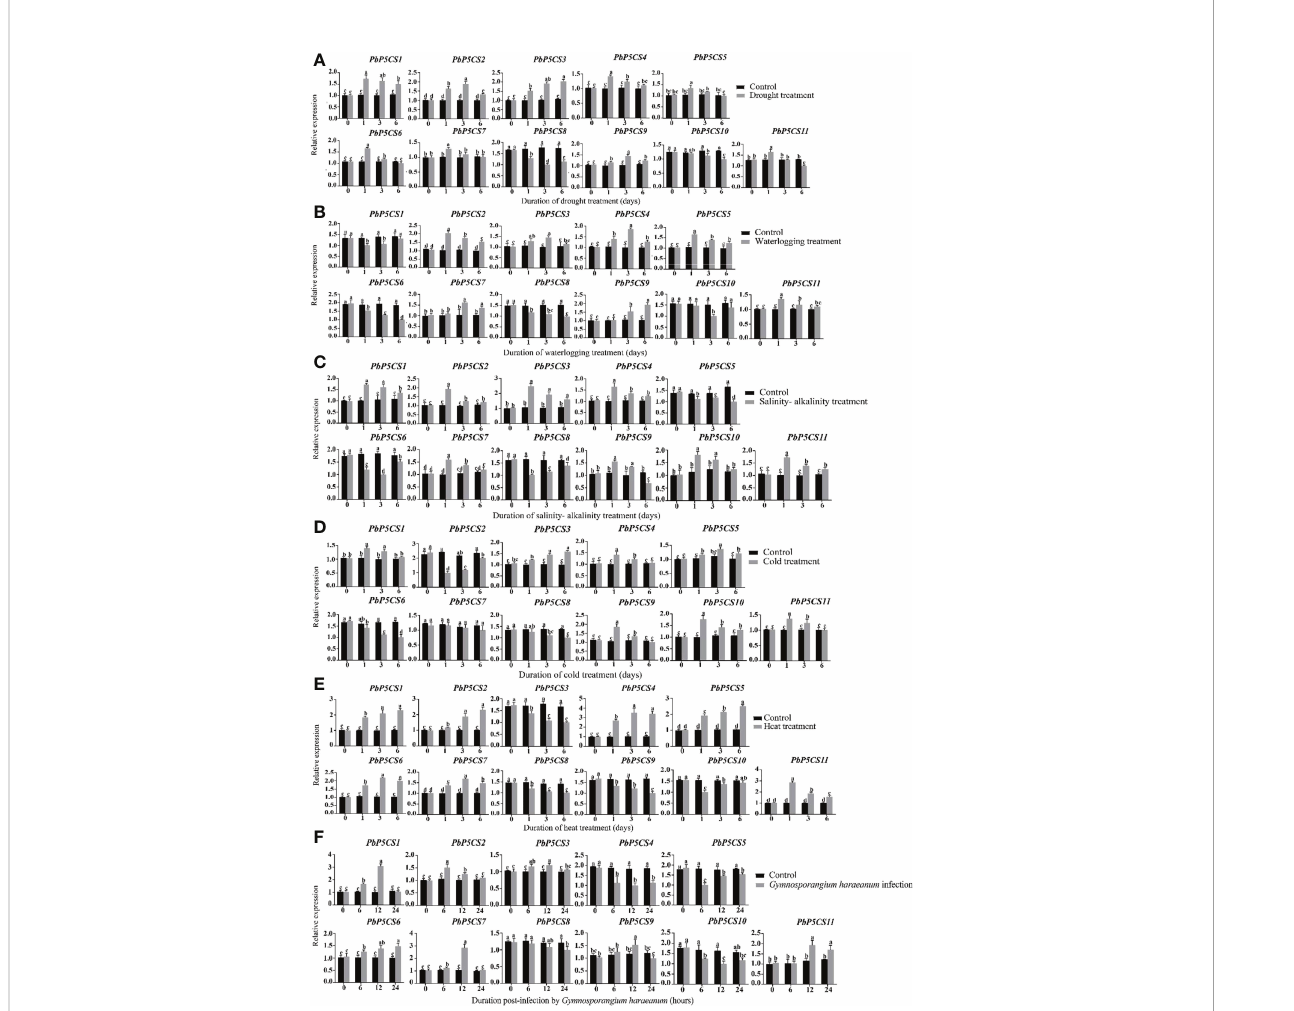
FIGURE 8 Real-time quantitative PCR (qPCR) analysis of pear P5CS genes in response to (A) drought, (B) waterlogging, (C) salinity-alkalinity, (D) cold, (E) heat, and (F) Gymnosporangium haraeanum infection stresses. Data were normalized against expression levels of the Actin gene. Mean values were calculated from three independent replicates. Vertical bars indicate standard error of the mean. Different lowercase letters indicate signi fi cant differences between treatments according to Fisher ’ s least signi fi cant difference (P <